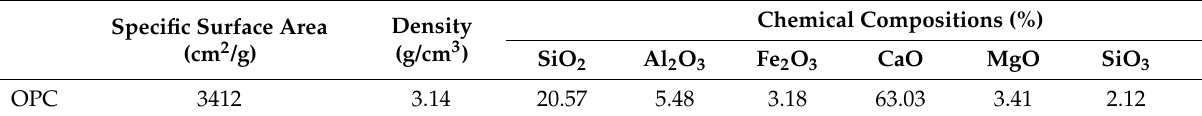
Figure 1. Schematic of arc thermal metal spray system. Table 2. Chemical composition and properties of OPC used in present study.